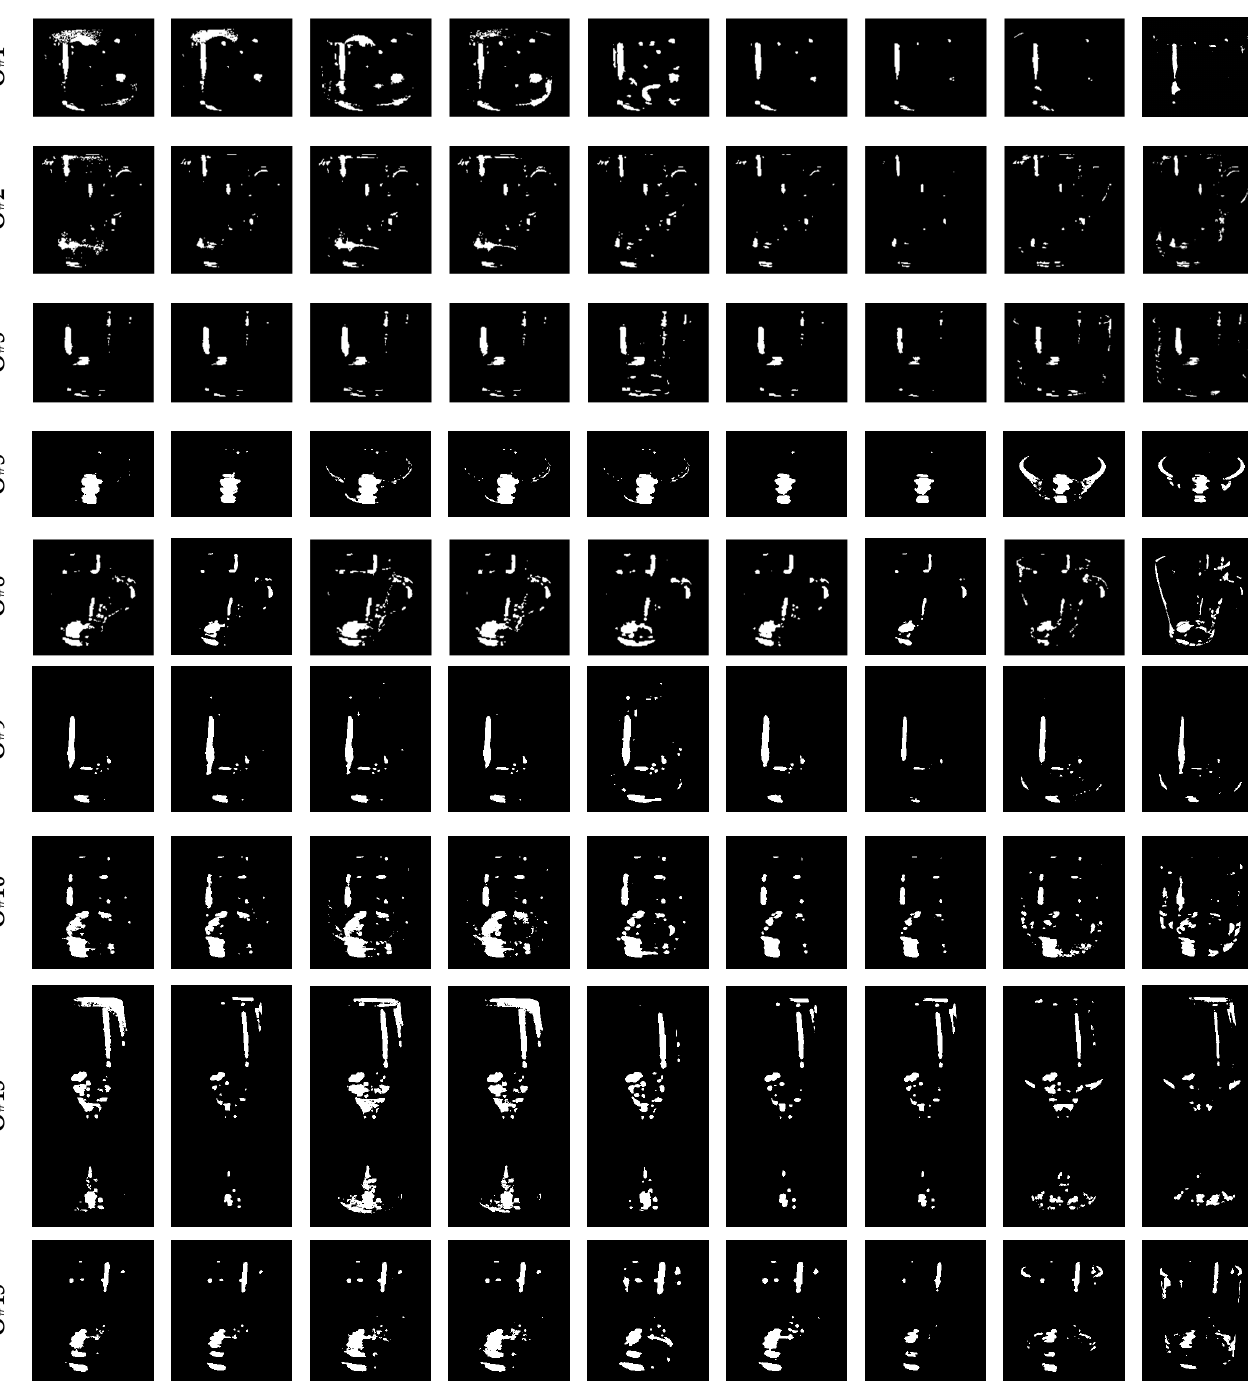
Figure 13. Comparison of SRD accuracies of different methods for sample objects in MSPLFI dataset.